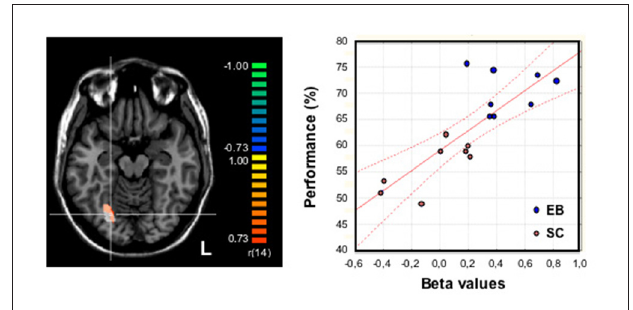
FIGURE 4 | Relationship between olfactory performance and brain activity during odor processing (odor discrimination and categorization). Activation maps were obtained from an analysis of covariance on olfactory conditions plotted together in 16 (8 EB) subjects using their averaged performance in odor free-identification, categorization and discrimination as the covariate (the ability to discriminate, categorize and identify 30 odor samples was assessed before the fMRI study and further averaged to provide a global odor recognition performance expressed in percentage). Brain regions with a positive covariation ( p = 0.001 uncorrected, with a cluster size threshold correction of p = 0.05 based on Monte Carlo simulation) were superimposed on the transversal view of a normalized MRI brain of a representative subject. An activation focus was found in the right fusiform gyrus [FG, in orange-yellow: 380 mm 3 (center of gravity: x : 24, y : − 64, z : − 13)] that largely overlapped a brain area that had been identified in the group comparison (EB − SC) for olfactory processing and displayed here in white color as a reference. The crosshairs intersect on a voxel in the right FG ( x : 24, y : − 67, z : − 13). The graph at the right part of the figure shows the strong correlation between brain activity (beta weights) in the right FG during odor processing (white region) and the individual performance (averaged score, %) in the whole group of subjects ( n = 16): r = 0.80; p = 0.001. The red lines indicate the confidence interval (CI, 95%). EB, early blind; SC, sighted control (studied blindfolded); L, left hemisphere. Adapted from Renier et al.